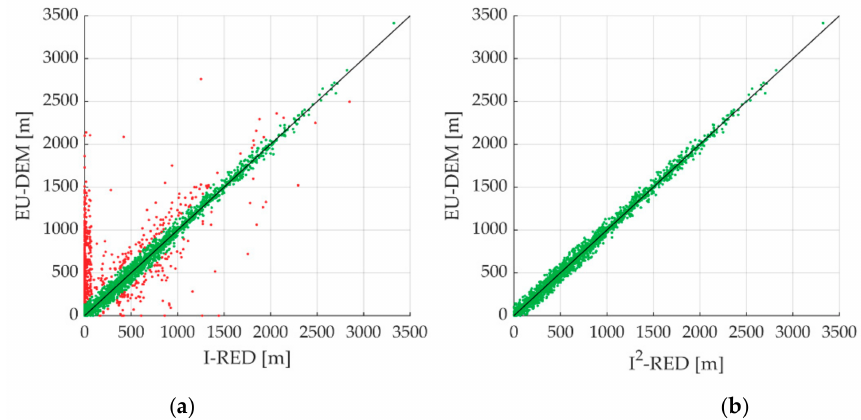
Figure 4. Comparison between the elevation values before ( a ) and after ( b ) the quality control. The red dots in ( a ) identify the rain gauges included in I-RED that are characterized by an elevation discrepancy greater than 150 m, while the green ones identify rain gauges with a discrepancy lower than 150 m. ( b ) refers to the same information for the I 2 -RED